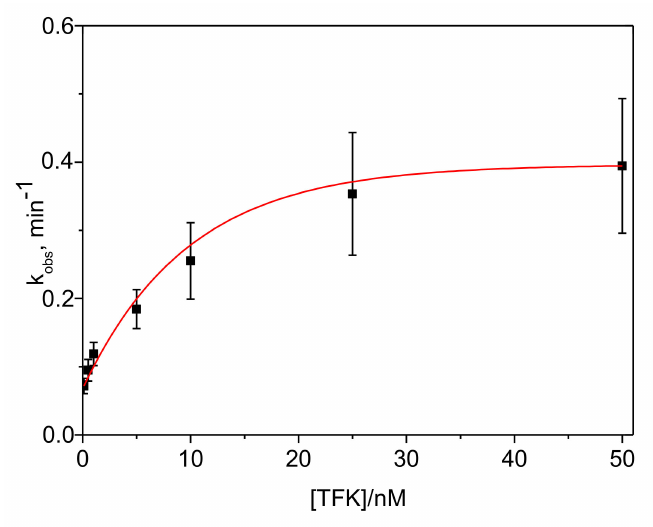
Figure 4. Typical dependance of k obs as a function of TFK concentration for inhibition in the presence of 0.1 mM ATC. The k obs values were determined from nonlinear fitting of progress curves in Figure 2 at three substrate concentrations. Data were fitted to Equation (3): ordinate is k − 4 and asymptote is k − 4 + k + 4 in Scheme of Figure 5.